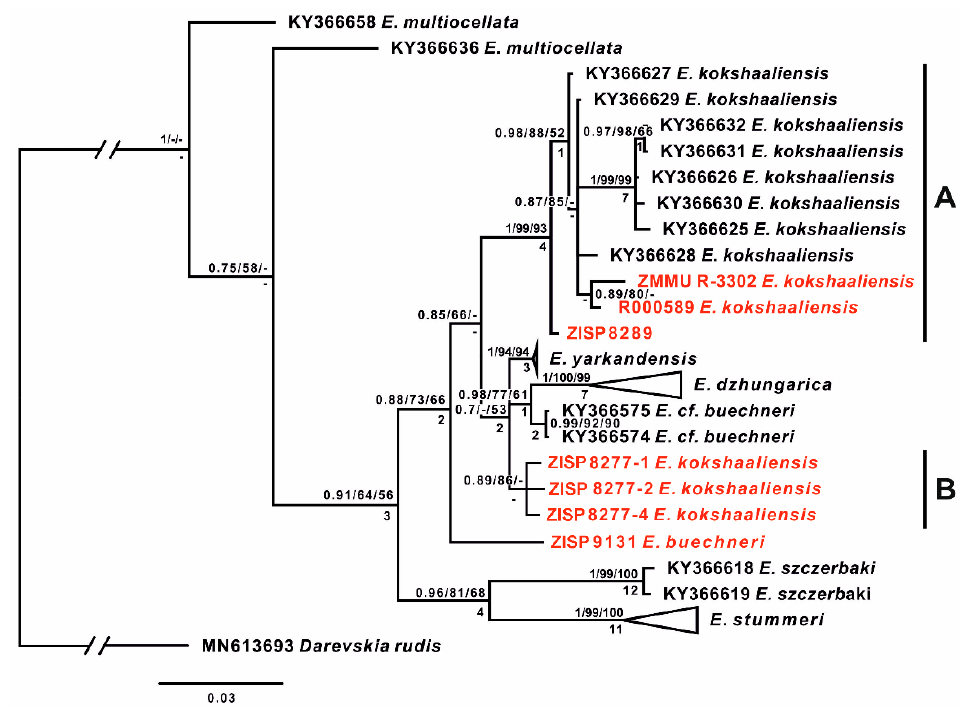
Figure 2. The tree resulted from the Bayesian inference analysis of the studied samples of Eremias multiocellata complex. Values at nodes indicate posterior probabilities/bootstrap support for BI/ML analyses, respectively. The “-” sign shows that the node exists on the Bayesian tree, but the topology is different in the specified analysis. Numbers below the nodes represent decay indices for parsimony tree. Red labels highlight sequences from historical specimens.